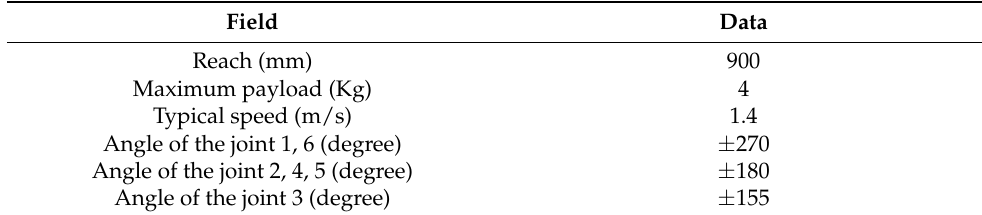
Figure 6. Image of the Omron TM5-900 collaborative robot used for the case study. Table 1. Specifications of collaborative manipulator